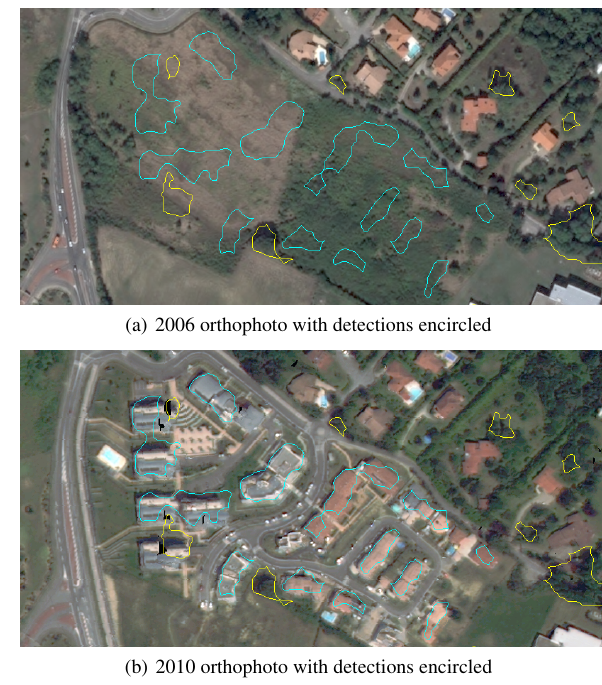
Figure 5: Constructions correctly detected over the Toulouse area by our method (cyan=constructions, yellow=destructions).